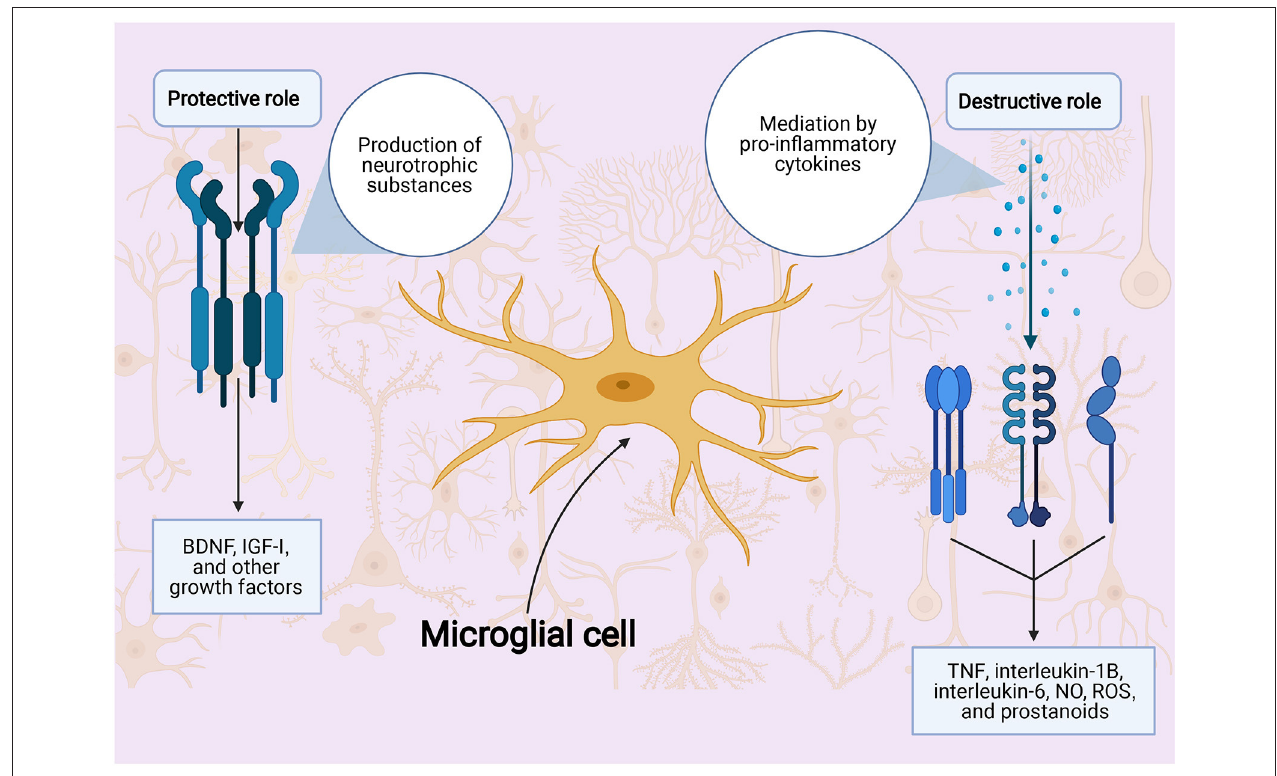
FIGURE 2 | Role of microglial cells in ischemic stroke injury. BDNF indicates: NO, nitric oxide; ROS, reactive oxygen species; TNF α , tumor necrosis factor α .